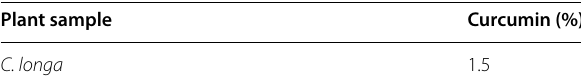
Table 4 Quantification of curcumin in the methanolic fraction